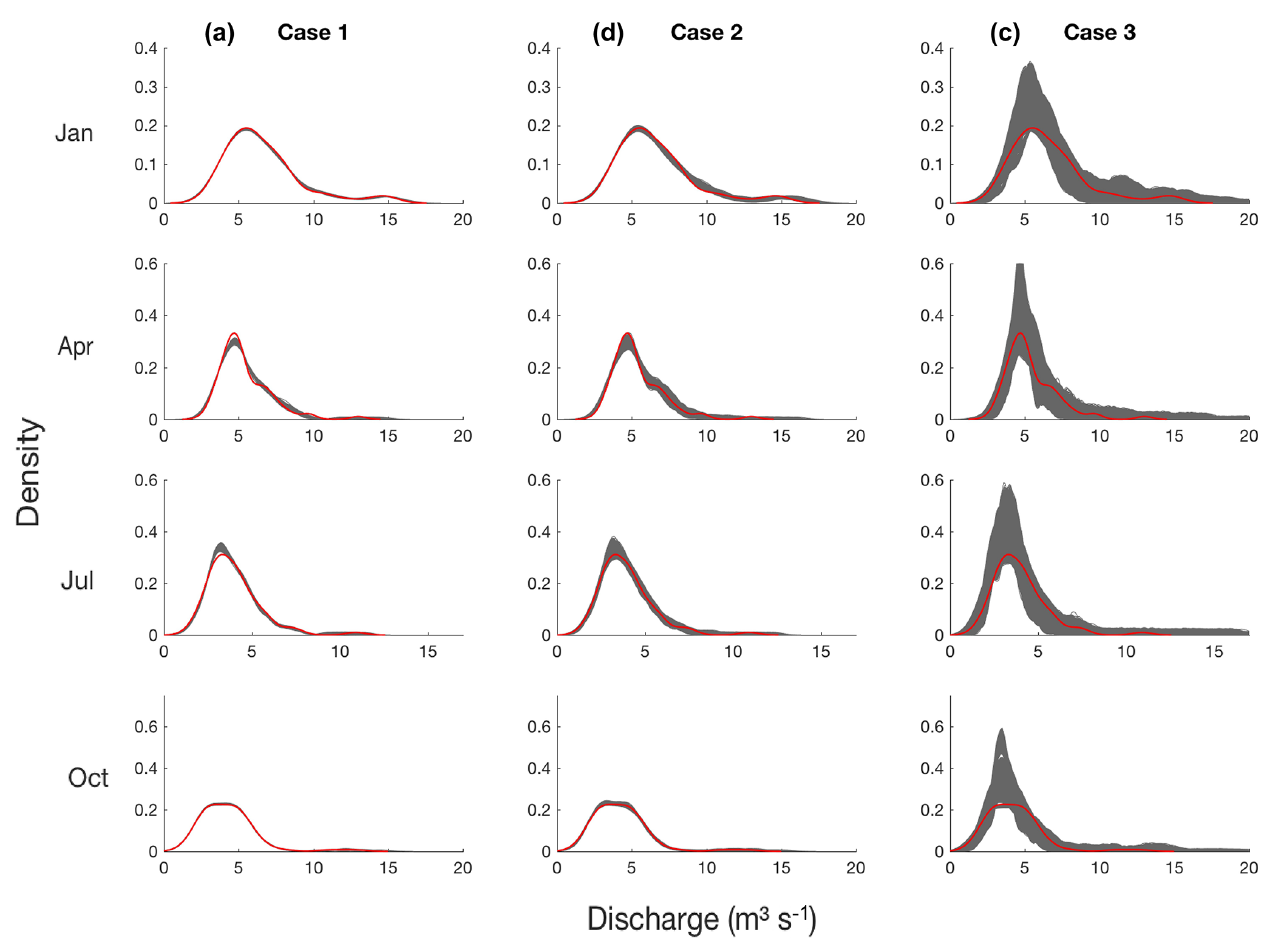
Figure 17. Comparison between the probability density functions of the mean of discharge of the observed and simulated values in three cases. Reference discharge Q rf is in red and the time series of simulated discharge is in